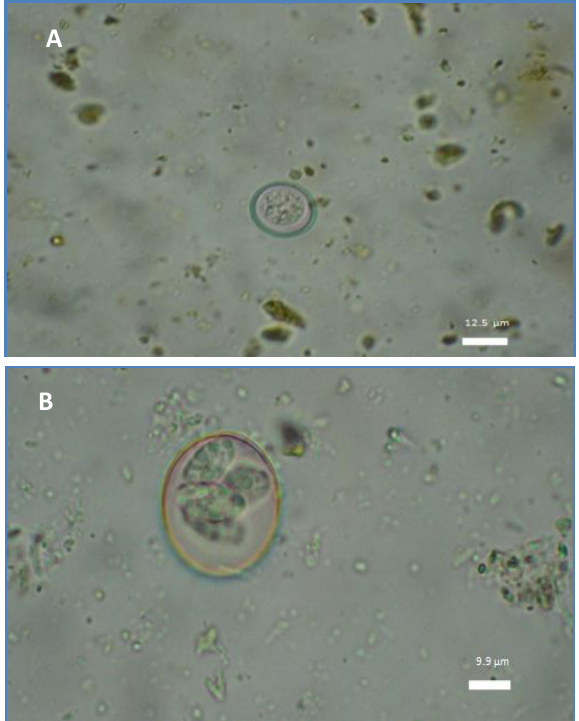
Figure, 1: Eimeria alijevi , round Oocyst with no micropyle or cup (A) with four elongated sporocysts in full sporulated Oocyst (B) by saturated salt solution (X100).